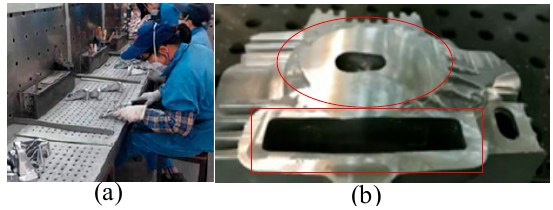
Figure 1. Casting post-processing site. ( a ) grinding scene ( b ) grinding effect (Based on practice, vibration can easily occur when grinding the red area of the cavity). During manual grinding, there is a long period of intense vibration exposure in the grinding process of hand-held workpieces, which causes arm vibration syndrome and harm to workers’ physical health [2]. Frequent vibration will also cause harm to the grinding workpiece and tools, because the tools and workpiece are vulnerable to damage during large vibrations. During mechanical grinding, a large holding force is needed to